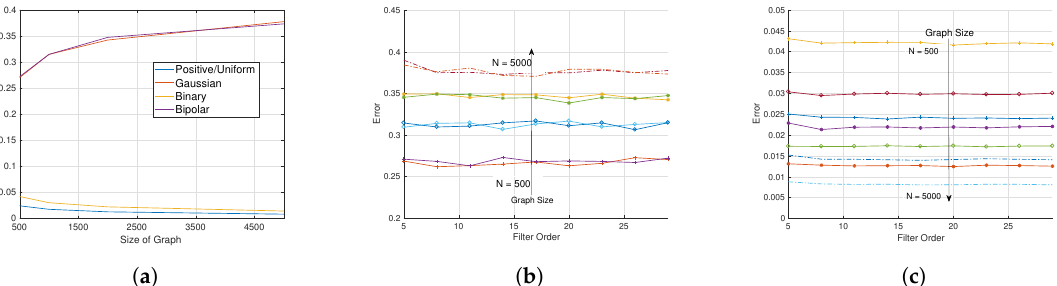
Figure 8. Approximation error for graph filtering using the proposed hierarchical decomposition for different kinds of inputs. ( a ) Comparison of the approximation error for graph with varying number of nodes and filter order K = 30. Comparison of the approximation error for different filter orders for ( b ) Gaussian and bipolar signals and ( c ) positive and unipolar